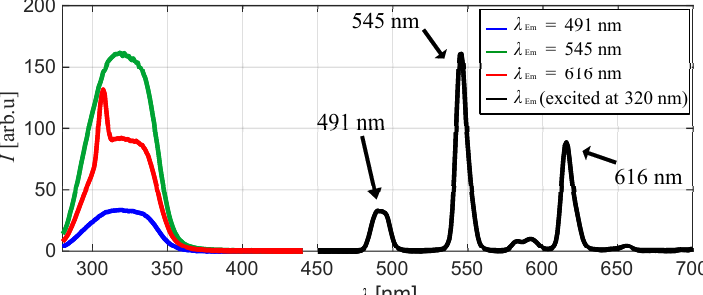
Figure 4. Excitation and emission spectra of the chameleon luminophore in the